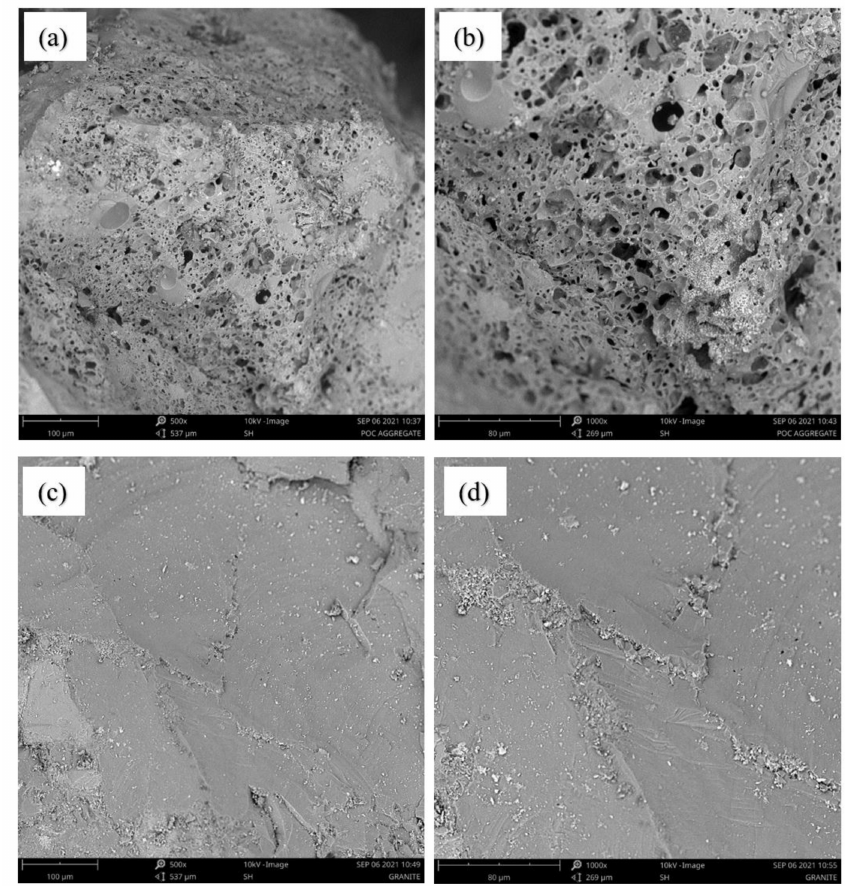
Figure 5. Scanning electron microscopy images for POC aggregates surface texture at ( a ) 500 × and ( b ) 1000 × magnifications, and granite aggregates at ( c ) 500 × and ( d ) 1000 ×